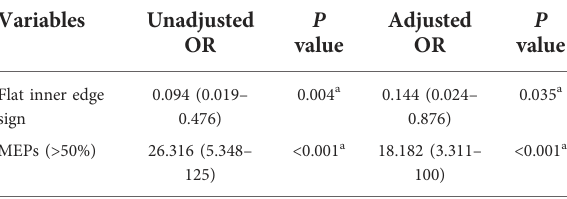
TABLE 3 Multivariate logistic regression analyses for estimating risk factors for core